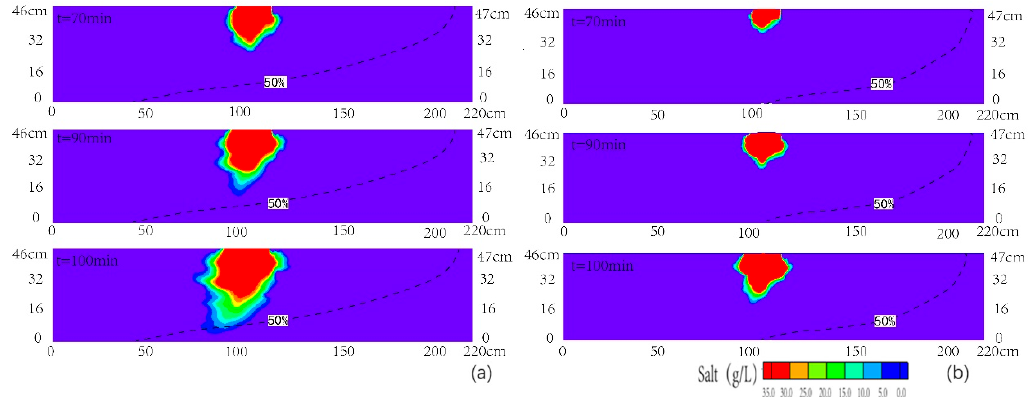
Figure 8. Simulated spatial saltwater contamination concentration distributions for ( a ) increasing dispersivity and ( b ) decreasing dispersivity at different times. The black dashed line denoted the contour line with the concentration of 0.5 time of seawater concentration.